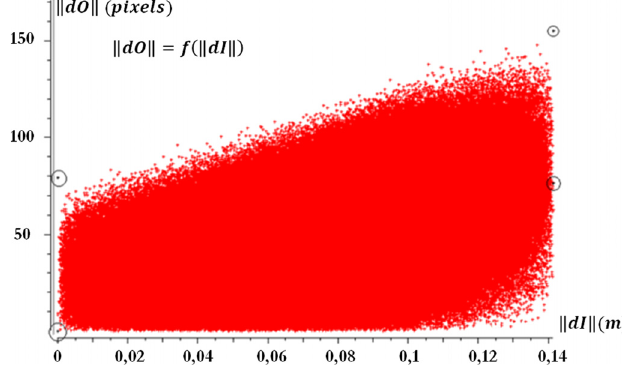
Fig. 24. Comparison between Monte-Carlo and intervals for estimating uncertainties of pinhole model.